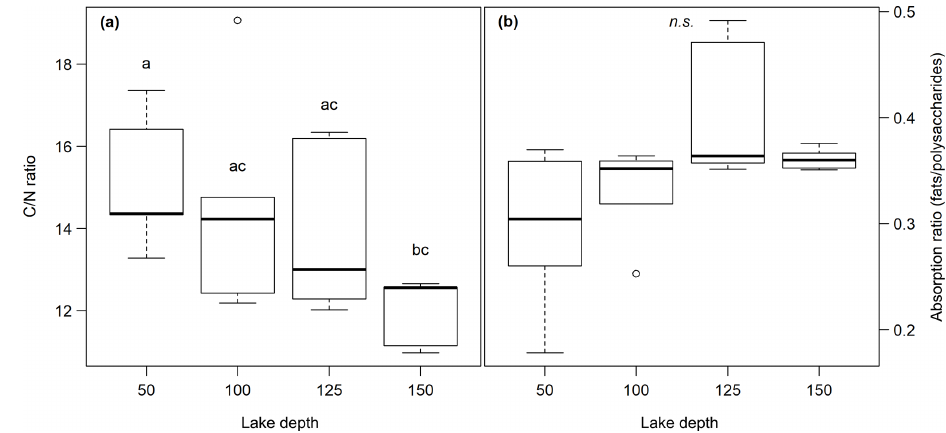
Figure 2. (a) C / N ratio and (b) absorption ratio of fats and polysaccharides at different lake depth categories. Identical lowercase letters indicate C / N ratios that were not significantly different (i.e., p> 0 . 05) from each other. In the figure, n.s. means that absorption ratios did not exhibit significant differences between lake depths. n (50, 100) = 5, n (125,150) = 6.